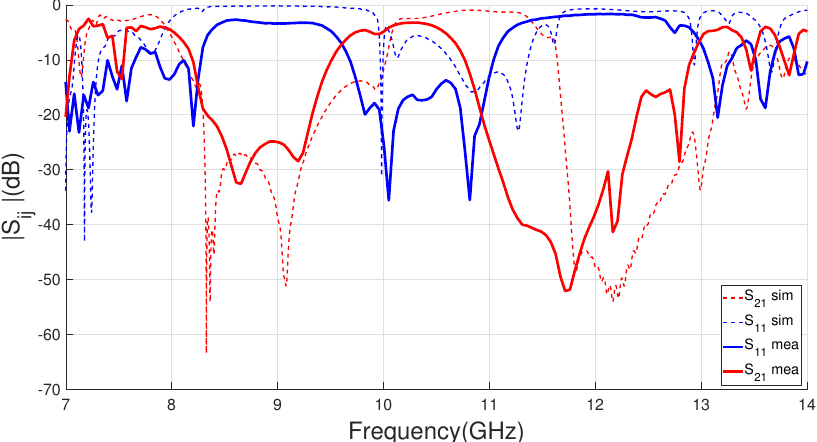
Figure 15. Photograph of the fabricated dual-band filter: ( a ) Perspective view (unstacked layers). ( b ) Filter test setup. ( c ) Front view with the detail of the printed layer with the resonators and the threads for the screws on the top plate.